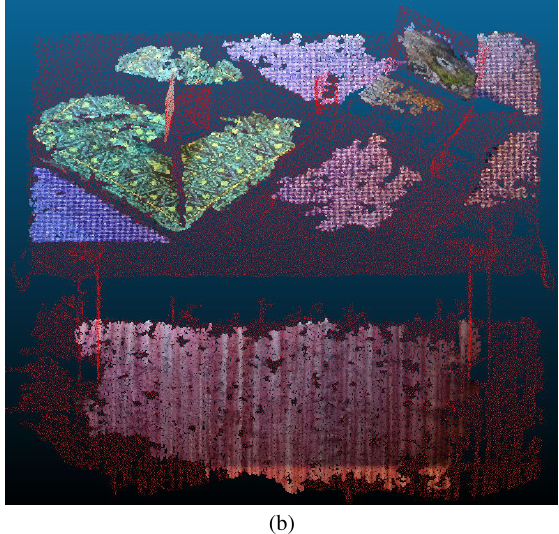
Table 8: Matrix of F-Test results for normalised heights. Figure 9: Quality of segmentation of a scene captured with a smartphone camera. (a) is the original cloud, (b) is the segmented one with segments in colour and unclassified points in red.